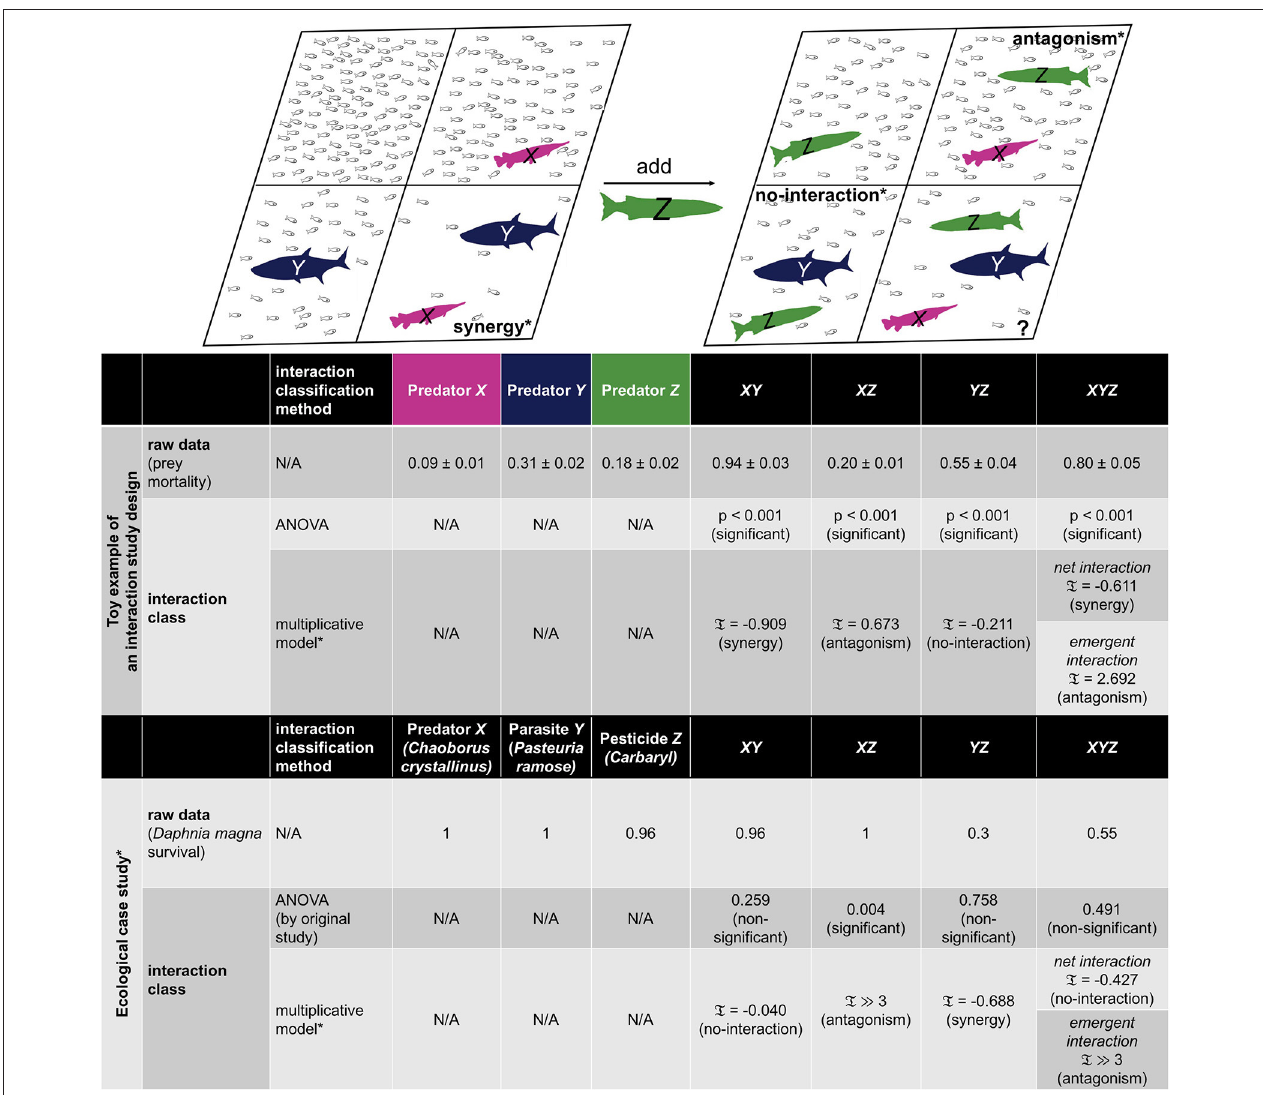
FIGURE 1 | Example representation and ecological case study of 2-way and 3-way interactions for consumer-resource systems. A toy example of an interaction study design for multiple predator effects (MPE) is given to represent 2-way and 3-way interactions, where mortality rates of prey population (small fish) are dependent on the consuming ability of certain predator or combination of predators. Schematic of no predator, single predator, pairwise combination, and triple combination of fish predator populations are illustrated in 8 different panels, where the pairwise panels of XY, XZ, YZ are chosen to represent the three distinct types of interactions: synergy, antagonism, and no-interaction by the multiplicative model with the rescaling introduced in Segrè et al. (2005) and Tekin et al. (2016). In particular, synergistic interaction corresponds to the case when the mortality rate with two predators is sufficiently larger than the expected mortality rate of predators based on single-predator effects. Conversely, predators can act antagonistically, meaning that the mortality rate in the presence of combined predators is sufficiently less than the expected mortality rate based on single-predator effects. In the latter scenario, predators do not interact, hence expected prey mortality is the same as actual prey mortality with both predators in the environment. Classification of interactions is typically done by evaluating the effects of the combined components relative to the effects of independent single components or lower-order combination effects. Given the raw data (see table), we employ the analysis of variance (ANOVA) as well as multiplicative model of interactions and present p -values and interaction measure calculations ( T , see section Methods for the definition), respectively. For 3-way combinations, two distinct types of interactions are characterized by the multiplicative model, where net interaction represents the overall effect and emergent interaction represents the three-way combination effect that is beyond any pairwise interactions. The same interaction study design has been performed for an ecological case study by Coors and De Meester (2008), where stressors are a predator ( X ), parasite infection ( Y ), and pesticide exposure by carbanyl ( Z ) on a water flea Daphnia magna survival. A MATLAB code package that has the toy data with the implementation of the interaction measure calculations are included as part of our paper (see Data Sheet 1 ). components (equivalently referred to as factors or